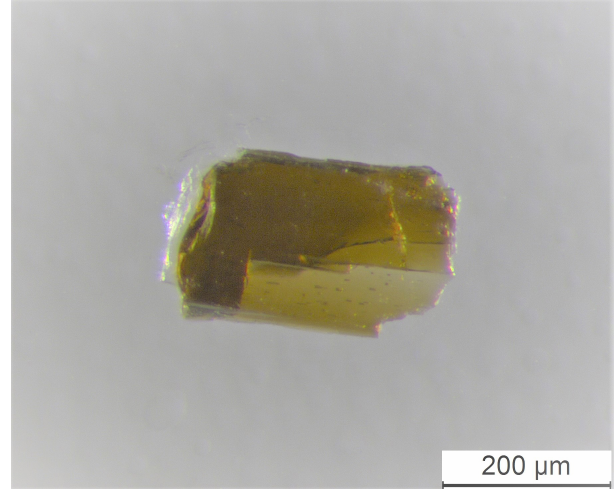
Figure 4. Crystal fragment of ferri-taramite used for SC-XRD study. Sample GEO-NRM